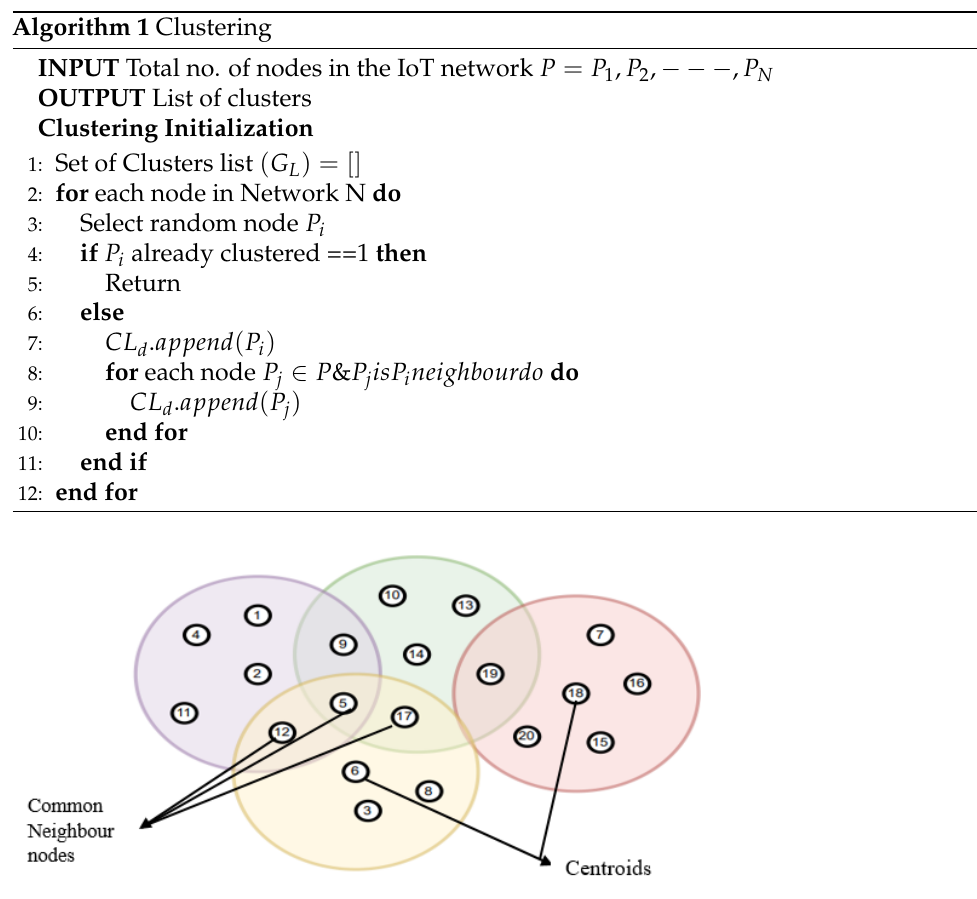
Figure 3. Example for